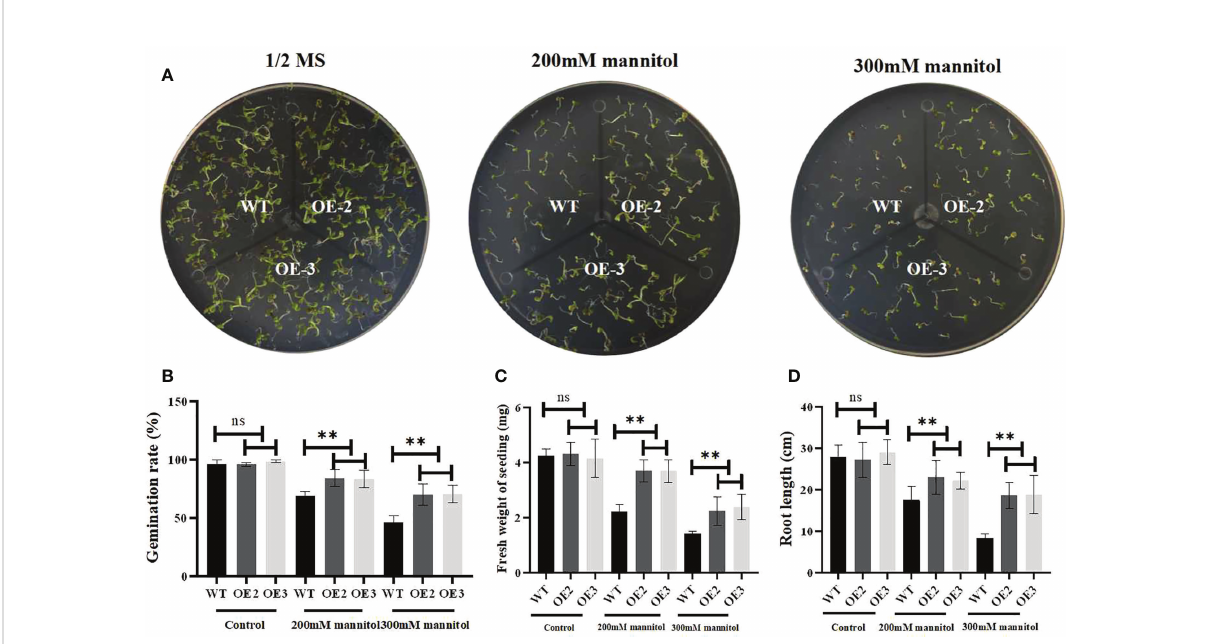
FIGURE 8 Drought stress responses of ZmLBD2-overexpressing transgenic Arabidopsis and wild-type plants. (A) Seedling growth by wild-type and ZmLBD2- overexpressing transgenic Arabidopsis plants under treatment with 0, 200, and 300 mM of mannitol for 5 days. (B) Statistical analysis of ZmLBD2- overexpressing transgenic lines and wild-type seed germination rates under 0, 200, and 300 mM mannitol, respectively. (C) Statistical analysis of ZmLBD2-overexpressing transgenic lines ’ and wild-type ’ s fresh weight under 0, 200, and 300 mM mannitol, respectively. (D) Statistical analysis of ZmLBD2-overexpressing transgenic lines ’ and wild-type ’ s root length under 0, 200, and 300 mM mannitol, respectively. Data were expressed as the mean of triplicate values, and error represented the SD. The ** represents p < 0.01, respectively. Non-signi fi cant